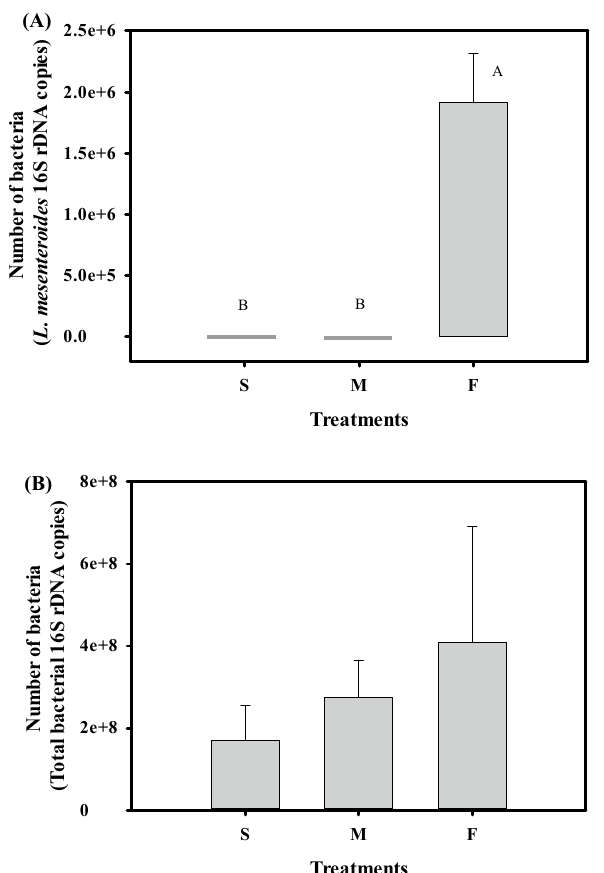
Figure 3. Bacterial colonization levels in the guts of honey bees fed with the Leuconostoc mesenteroides TBE-8 fermented broth. ( A ) The bacterial loads of TBE-8 were assessed through quantitative polymerase chain reaction (qPCR) by using a specific L. mesenteroides TaqMan probe. ( B ) Total bacterial loads were assessed through qPCR by using universal bacterial 16S rDNA primers. DNA samples obtained from the guts of 7-day-old workers fed with 50% sucrose syrup (S), MRS medium containing 50% sucrose (M), or the TBE-8 fermented broth containing 50% sucrose (F) since they emerged were prepared for qPCR. Data represent the mean of four repeats, with error bars indicating the standard deviation. Bars with different letters, A and B, indicate statistically significant difference ( P < 0.0001) according to the least significant